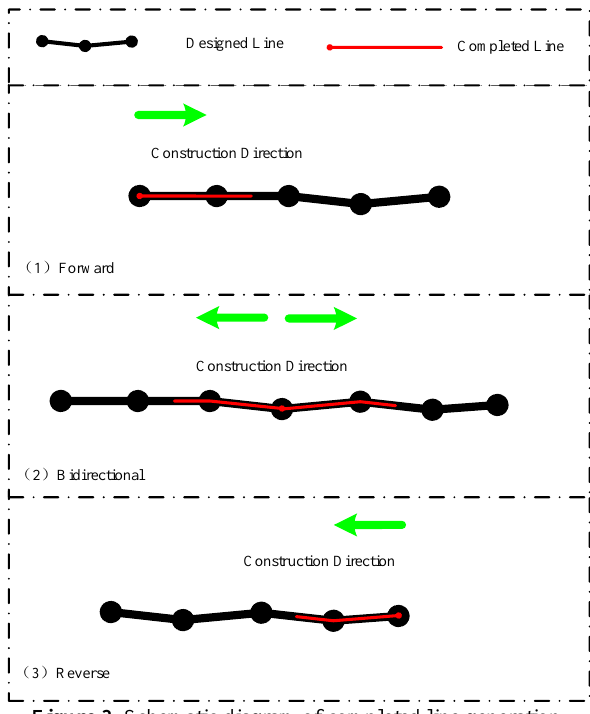
Figure 3. Schematic diagram of completed line generation